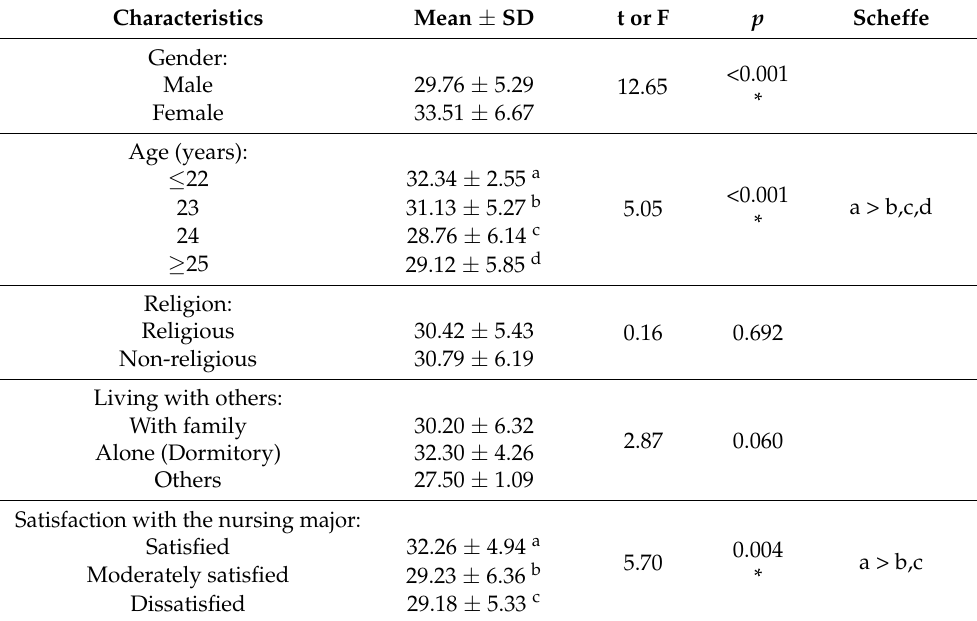
Table 3. Differences in academic achievement according to the general characteristics of the partici-